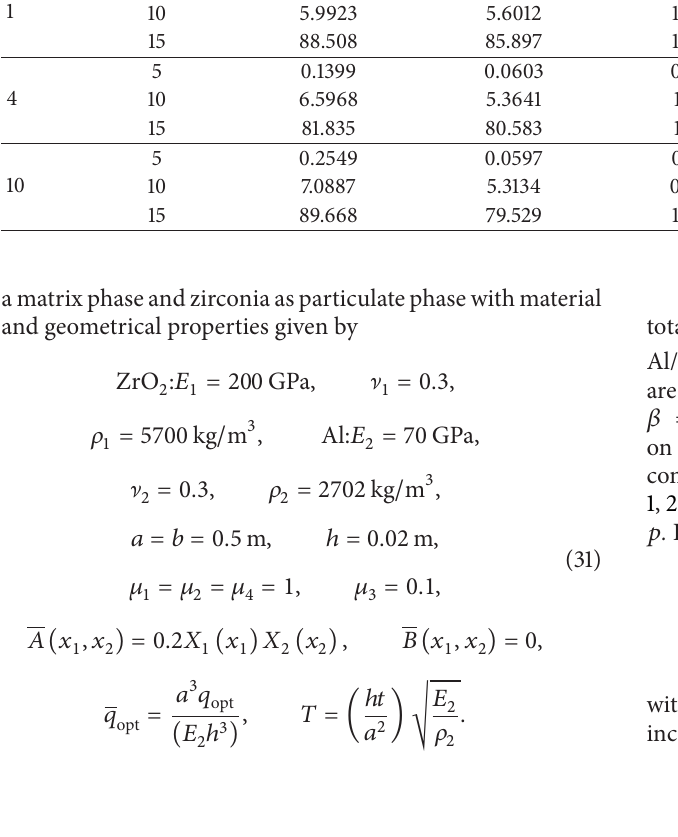
Table 3: Comparison of 𝑞